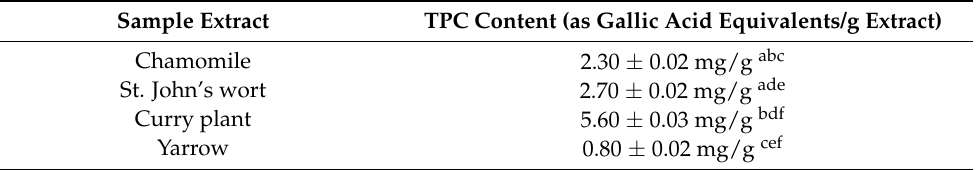
Table 3. Total phenolic content (TPC) of sample extracts (mean ± SD; n = 3) expressed as mg GAE (Gallic Acid Equivalents) per g of extract.